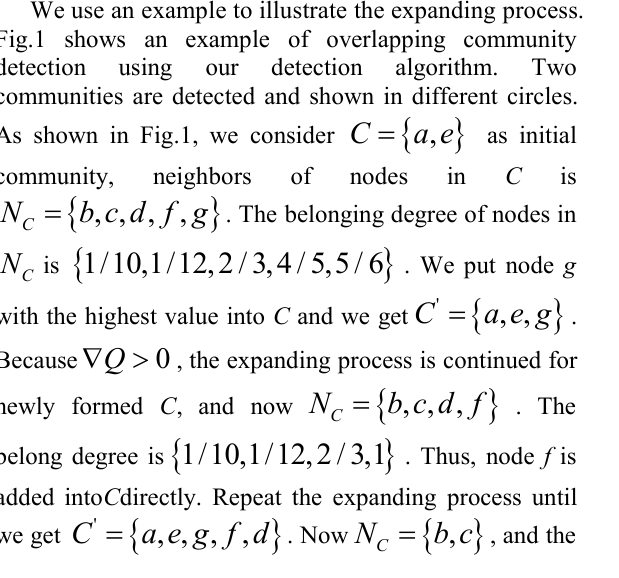
Figure 1. An example for community detection . We use an example to illustrate the expanding process.